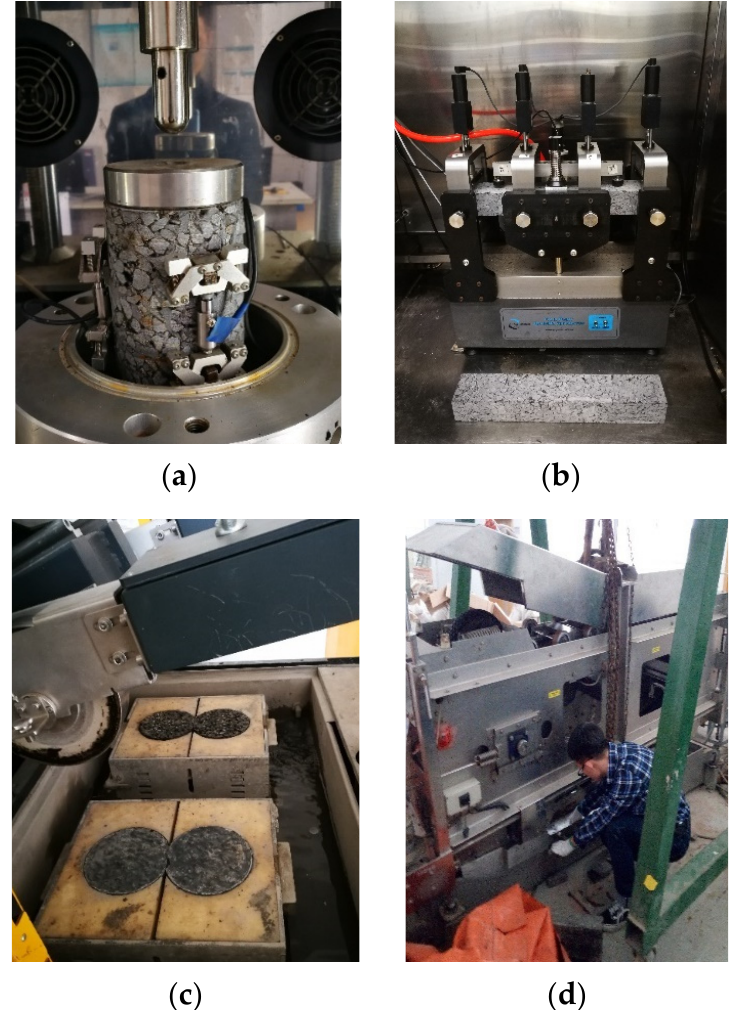
Figure 7. Performance tests of SFP. ( a ) Dynamic modulus test; ( b ) four-point beam fatigue test; ( c ) Hamburg wheel tracking test; ( d ) MMLS3 accelerated wheel tracking test. ( c ) Hamburg wheel tracking test; ( d ) MMLS3 accelerated wheel tracking